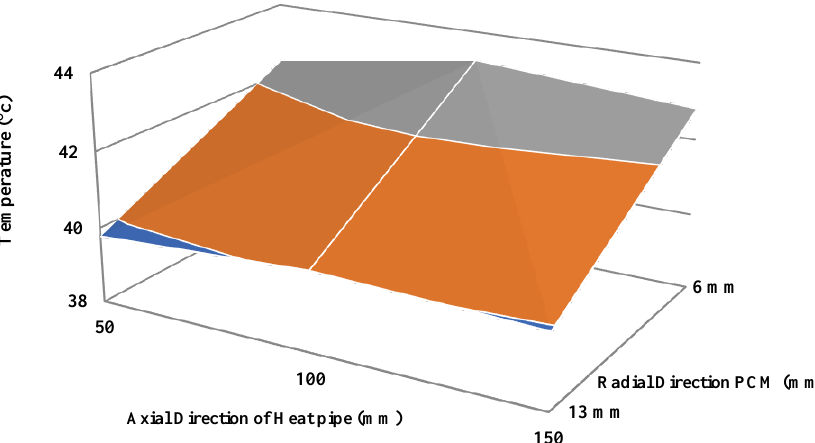
Figure 6. The temperature profile of the heat pipe and PCM at 1200 s in the charging mode (T = 70 °C).